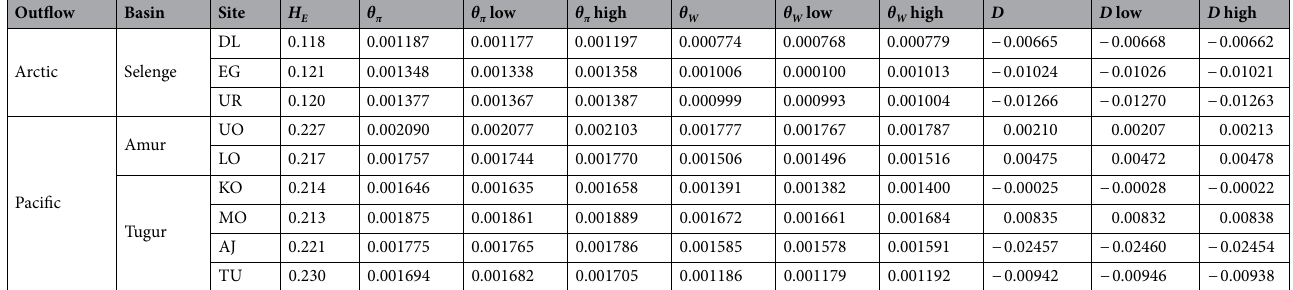
Table 2. Population genetic diversity for the full set of 174 individuals, including estimates based on population allele frequencies ( H E ) and those based directly on DNA sequence variation across the sampled genomic regions (the average number of pairwise differences between sequences, or θ π , the number of segregating sites, or θ W , and the scaled difference between these two, or Tajima’s D ). High and low columns represent upper and lower 95% confidence intervals for each metric.